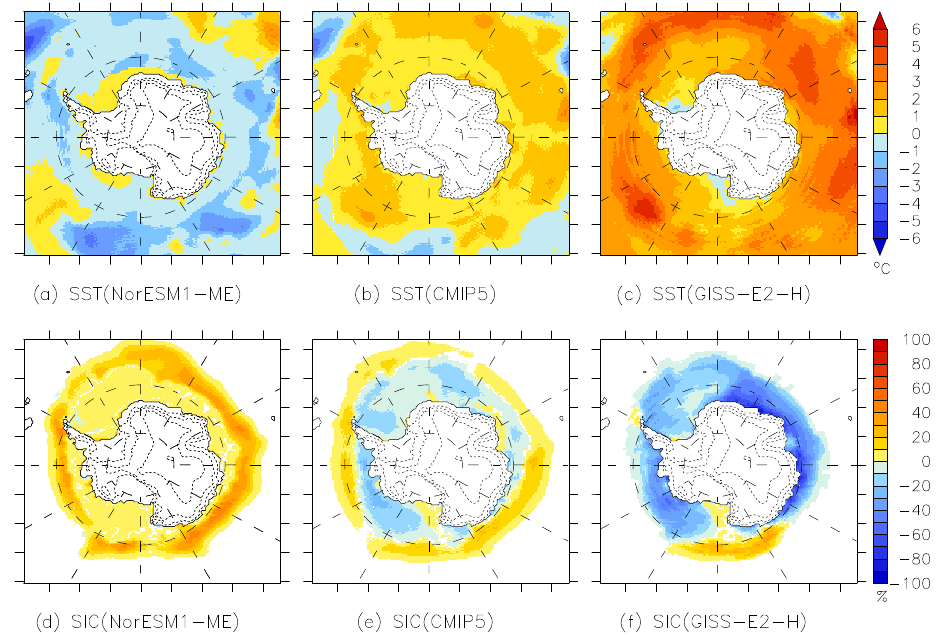
Figure 1. Top: SST anomalies ( ◦ C) of (a) NorESM1-ME, (b) CMIP5 average, and (c) GISS-E2 compared to ERA-Interim SST over 1979– 2005. Bottom: SIC anomalies (%) for (d) NorESM1-ME, (e) CMIP5 average, and (f) GISS-E2 compared to ERA-Interim SIC over 1979– 2005. These anomalies were introduced in the 6-hourly ERA-Interim